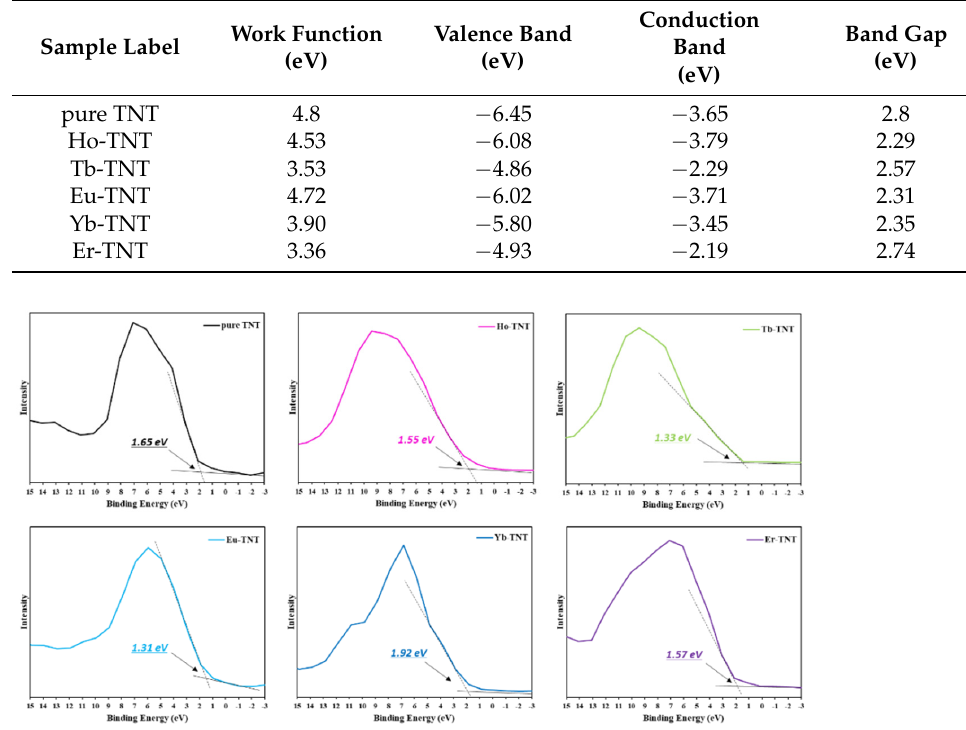
Figure 4. Valence band XPS spectra of pure TNT and lanthanide ‐ doped TNT.